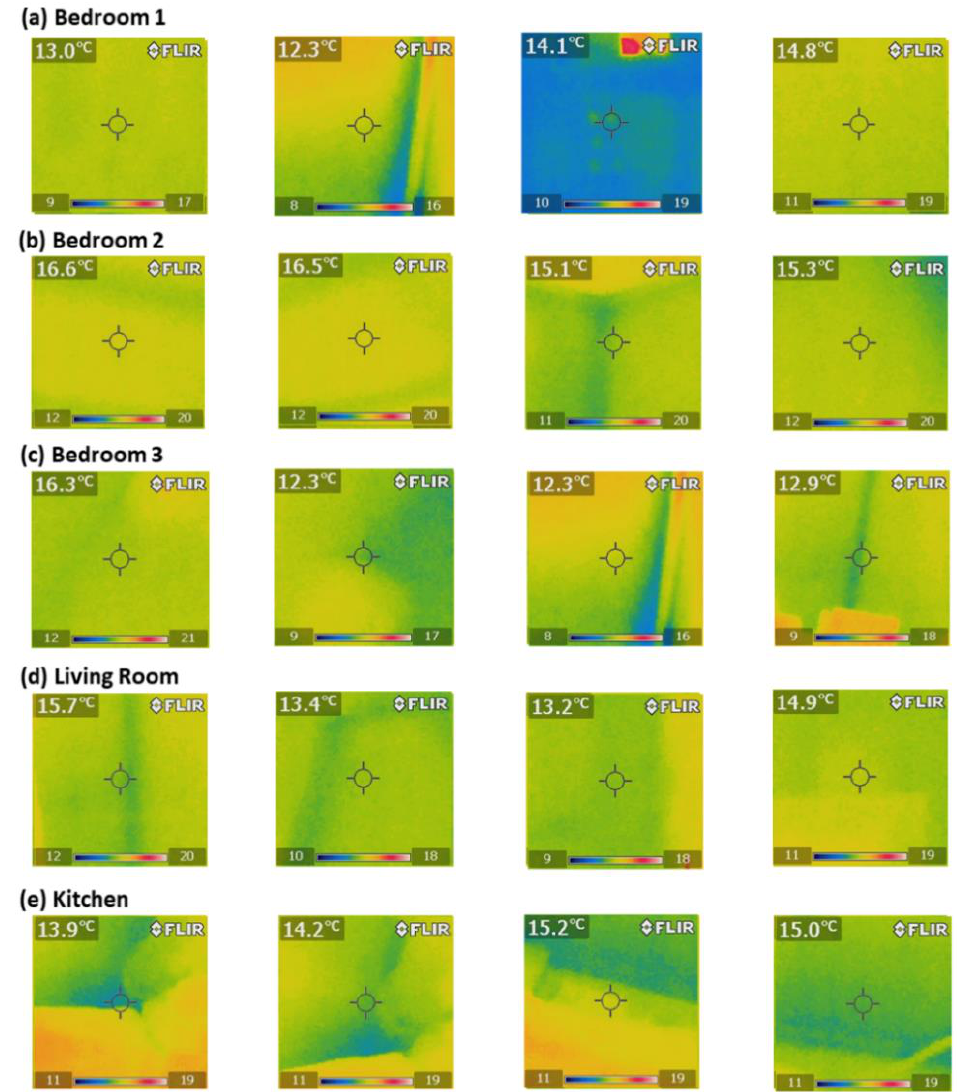
Figure 1. The thermal images for the house surveyed with four adults and one infant aged nine months old: ( a ) bedroom 1; ( b ) bedroom 2; ( c ) bedroom 3; ( d ) living room; and ( e ) kitchen. The red/orange colors in the image represent warmer areas and blue colors represent colder areas.